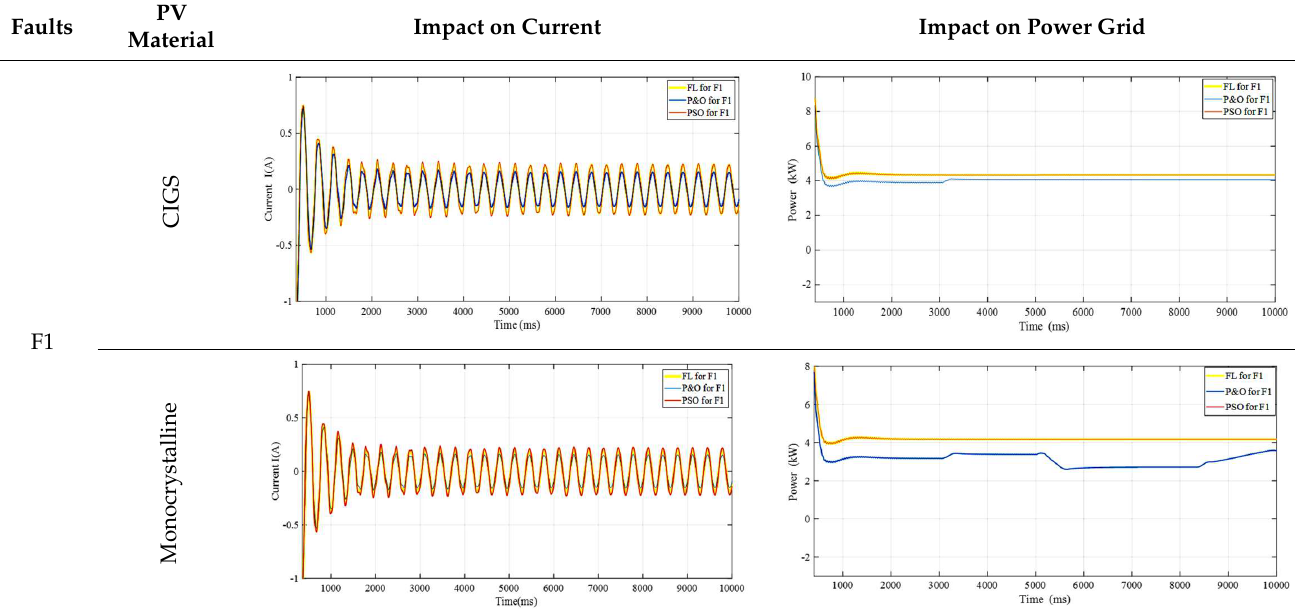
Figure 6. Fault States: ( a ) PV curve under various faults (monocrystalline). ( b ) PV curve under various faults (CIGS). Table 7. Simulation results.